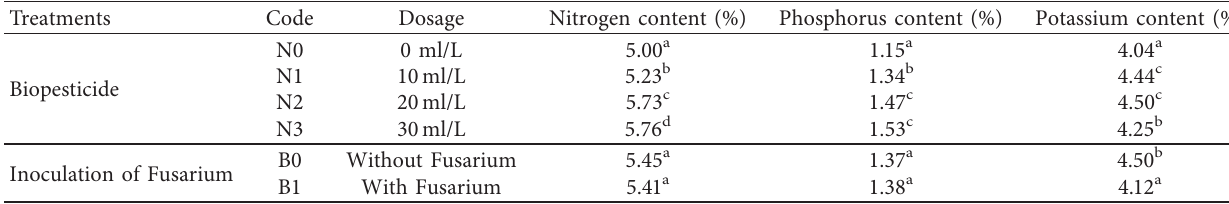
Table 1: Single factor of biopesticide dosage and Fusarium inoculation Treatments